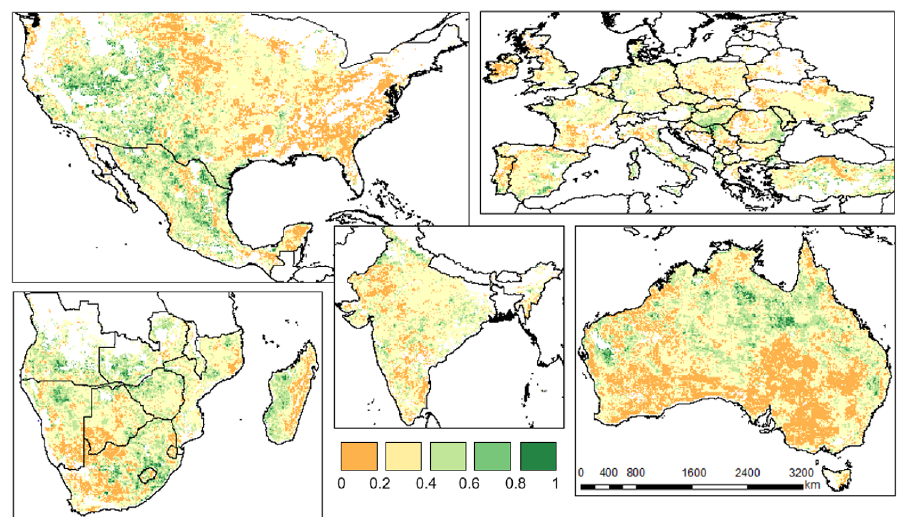
Figure 10. Maps representing the ensemble mean weighting factor for the LST dataset according to the error maps derived from the TC analysis.